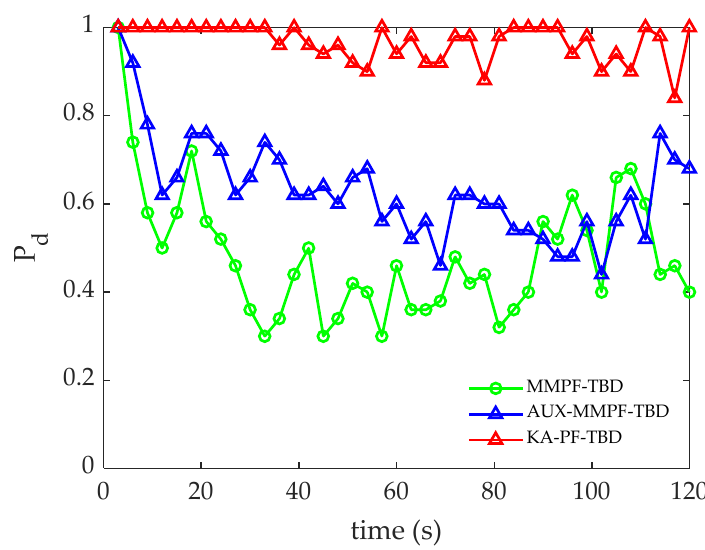
Figure 13. Accurate detection of probability sequences.